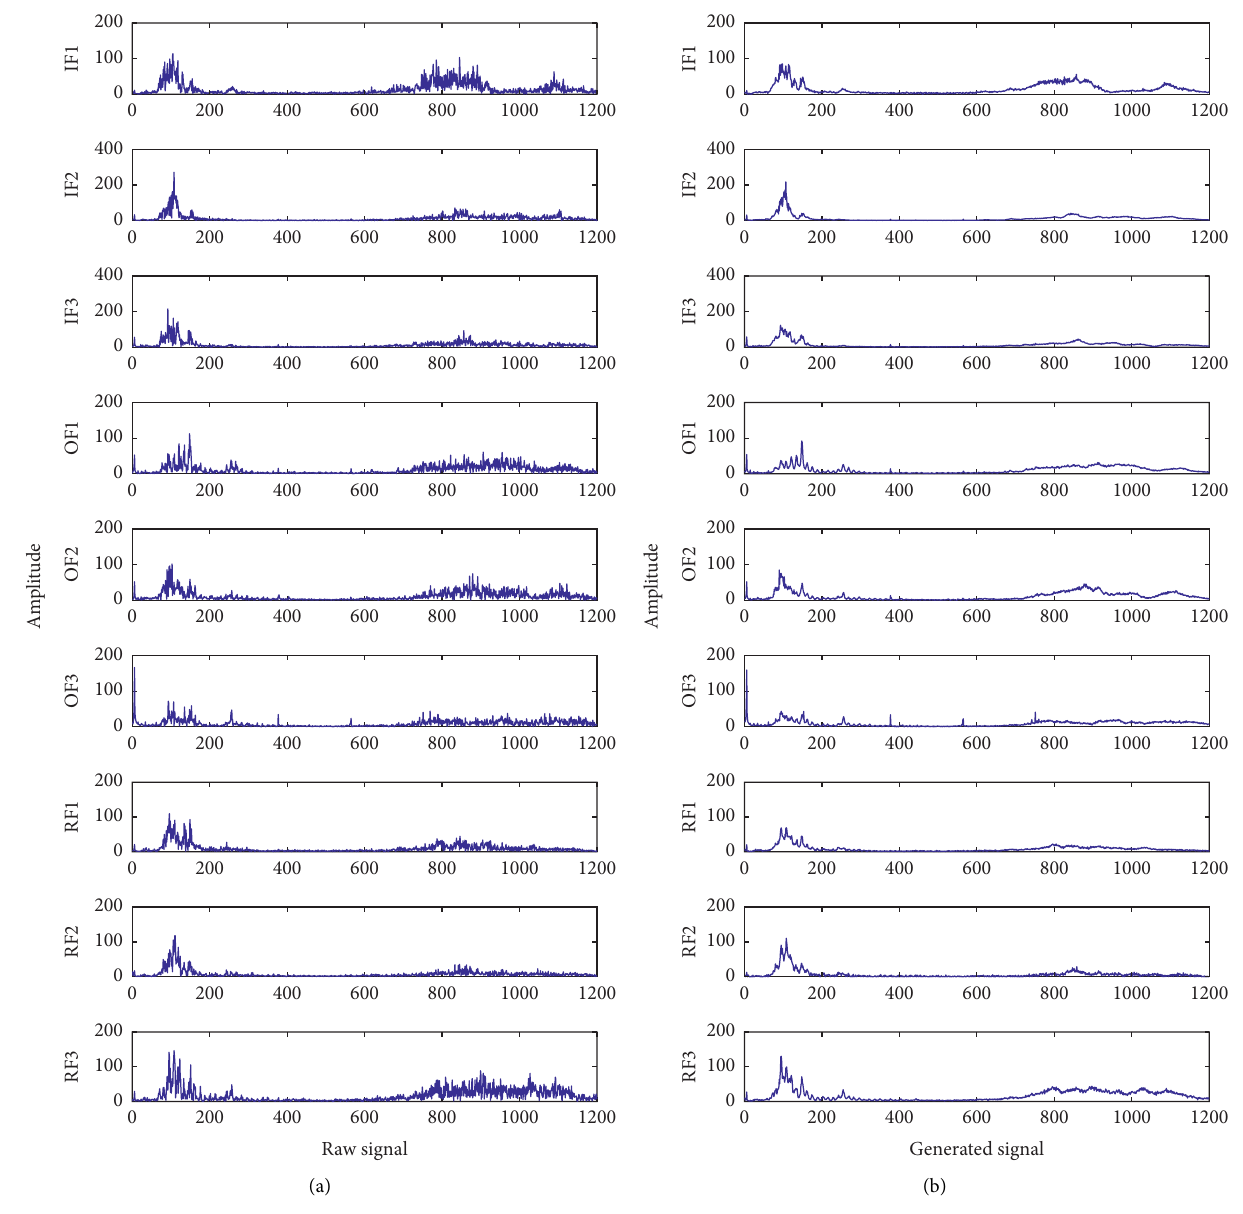
Figure 9: Raw signals and generated signals of the gearbox fault